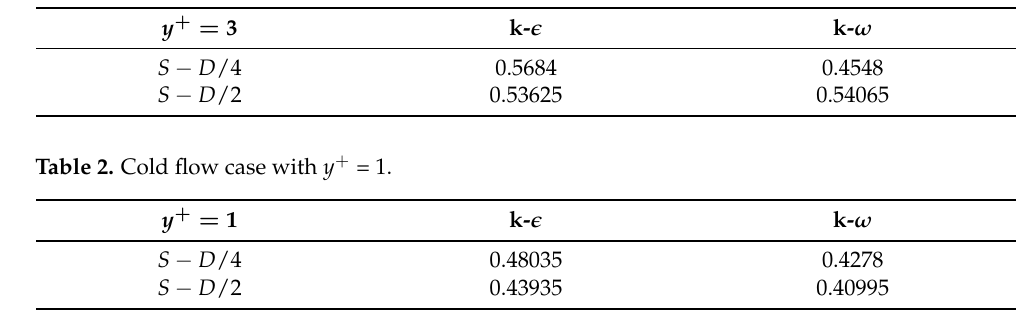
Figure 5. Axial velocity field comparison between k- (cid:101) y + = 3 ( left ) and k- (cid:101) y + = 1 ( right ). Table 1. Cold flow case with y + = 3.